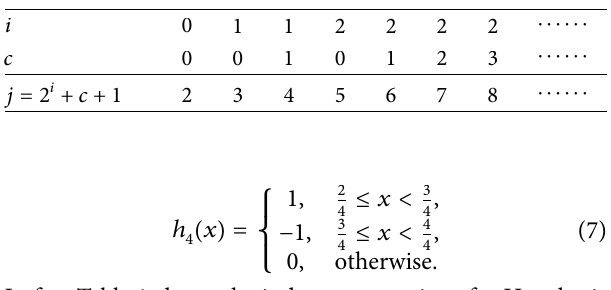
Table 1: Index computations for Haar basis